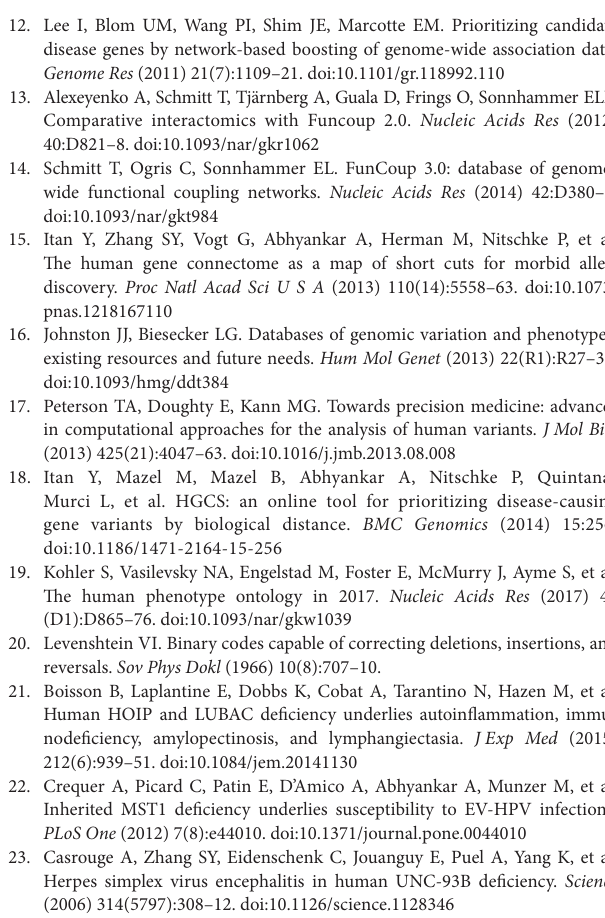
tABLe s1 | List of all CDGs, their associated HPO IDs and disease names. Also including the p -values and predicted routes between CDGs and candidate